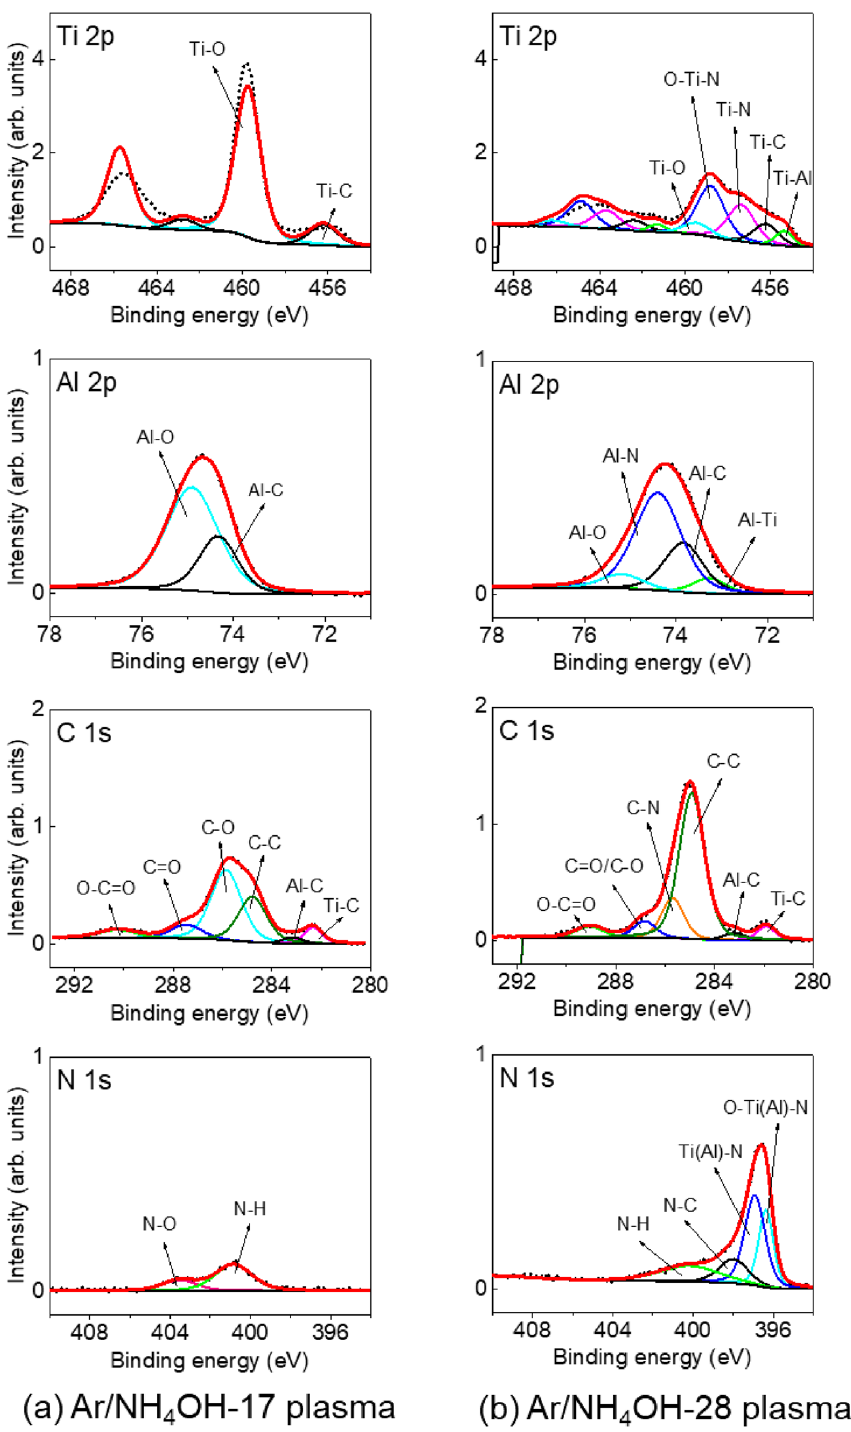
Figure 6. XPS spectra obtained on the surface of TiAlC film after exposure to ( a ) Ar/NH 4 OH-17 plasma and ( b ) Ar/NH 4 OH-28 plasma at 100 W and 0.64